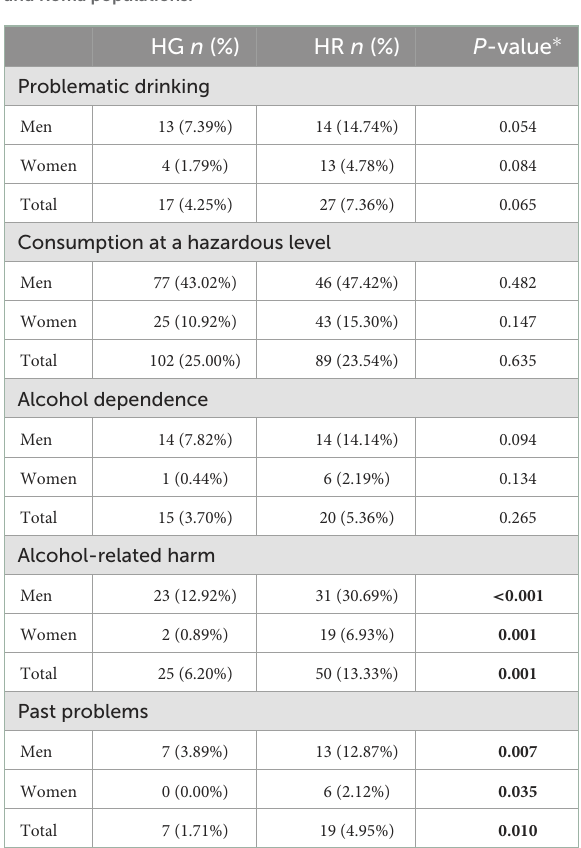
TABLE 4 Alcohol consumption behaviors of the Hungarian general and Roma